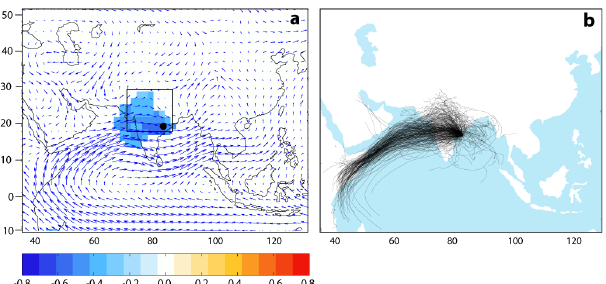
Fig. 2. (a) Correlation between JJAS δ 18 O p from nearest grid cell to the proxy and the precipitation rates in the surrounding grid cells using the IsoGSM model of Yoshimura et al. (2008). The analysis shows how upstream precipitation across India become aggregated in δ 18 O p at the proxy site. The vectors indicate the average surface wind fields during JJAS. (b) A composite of 2400 trajectories from 2002 to 2011 using the HYSPLIT model (Draxler and Rolph, 2003). Each trajectory was run for 90h from the proxy site and initialized twice per day at 06:00 and 12:00UTC at 1500ma . g . l